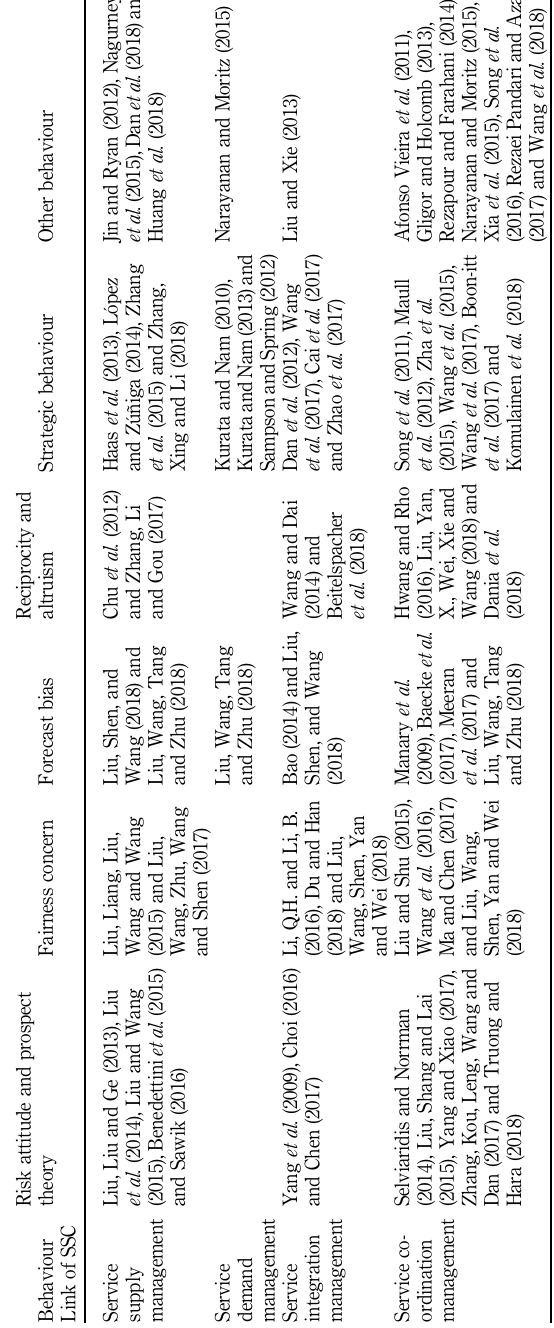
Table VI. Literature classification according to two